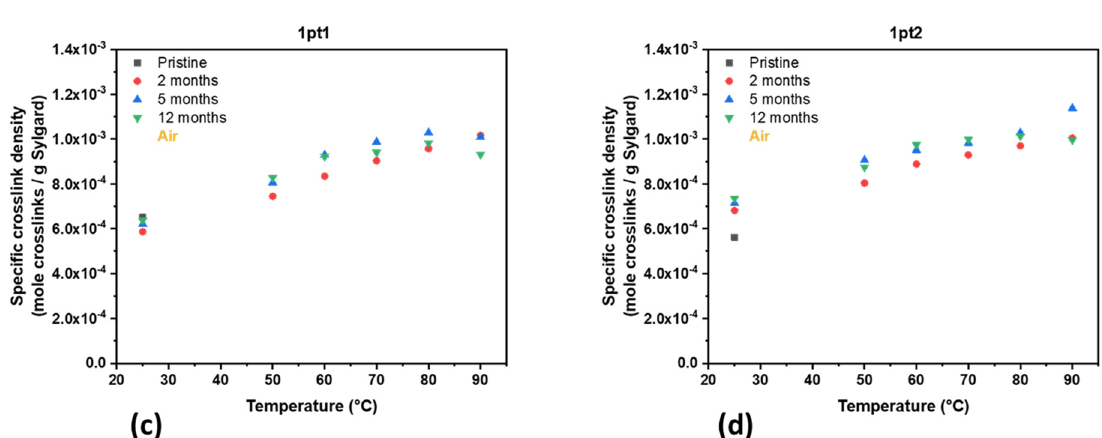
Figure A4. Specific crosslink densities of thermally aged samples: ( a ) Controls; ( b ) 0pt2; ( c ) 1pt1; and ( d ) 1pt2.